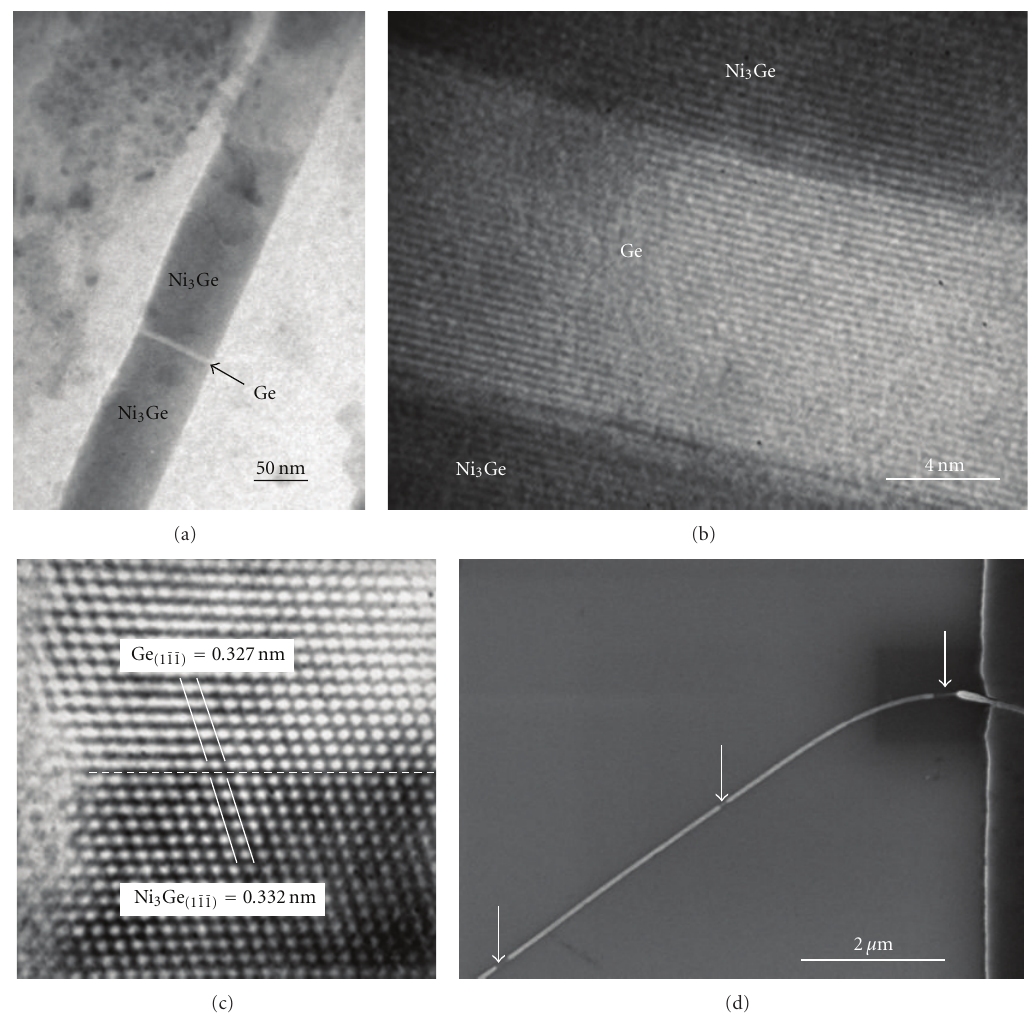
Figure 12: (a) TEM image of a fragmented Ni 3 Ge nanowire on the TEM grid upon 650 ◦ C annealing. (b) HRTEM image of the Ni 3 Ge/Ge/Ni 3 Ge nanowire heterostructure showing a clean and sharp interface. (c) Lattice-resolved HRTEM image of the Ni 3 Ge/Ge interface. The measured lattice mismatch was only 1.5% at the Ni 3 Ge(111)/Ge(111) interface. As a result, the twisted growth mode, which was observed in both Ni 2 Ge/Ge/Ni 2 Ge and Ni 2 Ge/NiGe/Ge/NiGe/Ni 2 Ge nanowire heterostructures to accommodate the large lattice mismatch, did not occur in this Ni 3 Ge/Ge/Ni 3 Ge nanowire heterostructure. (d) SEM image showing a broken Ge nanowire upon 650 ◦ C RTA due to a low melting pointing of the Ge nanowire. Reproduced from